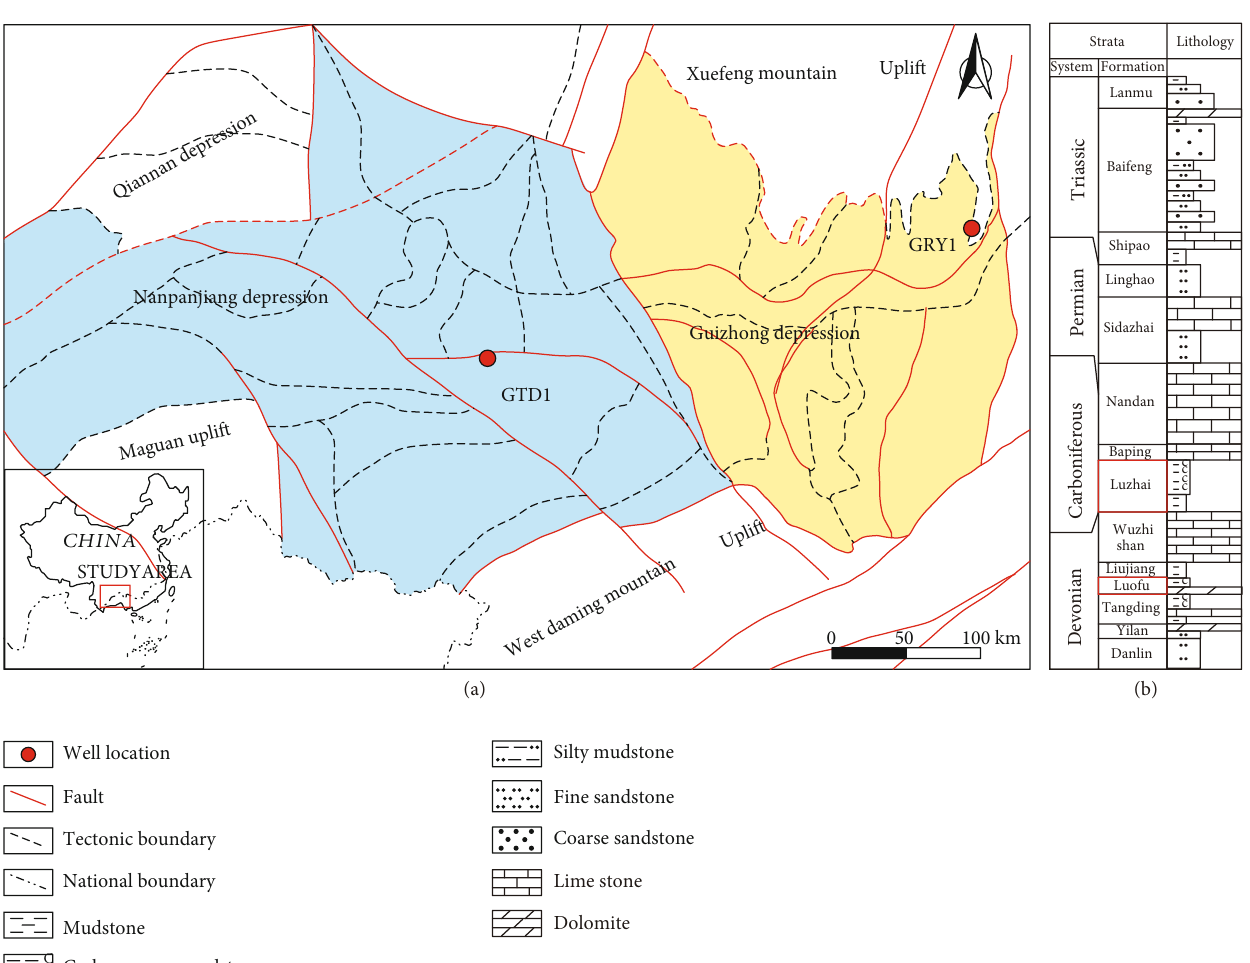
Figure 1: (a) The location of study area; (b) stratigraphic histogram of the study